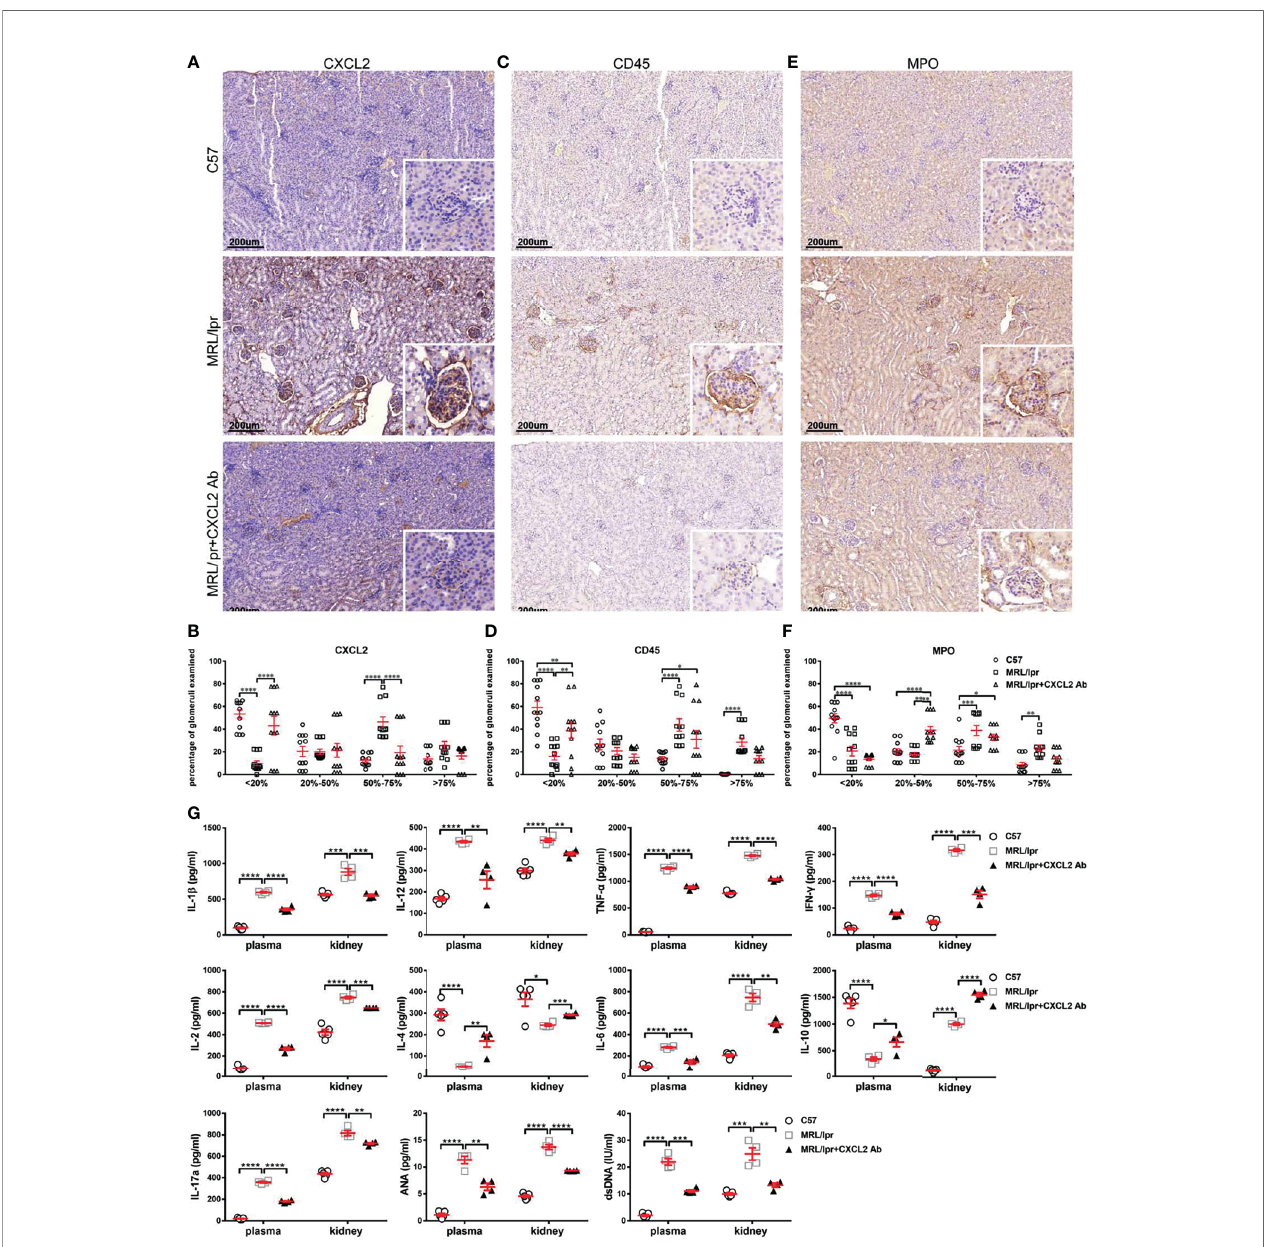
FIGURE 6 | Treatment with CXCL2 antibody inhibits in fl ammatory cytokine production in the MRL/lpr lupus model. (A, C, E) Representative images of CXCL2 (A) , CD45 (C) , and MPO (E) staining of kidney sections of mice from different groups. Inserts, details of a typical staining of the glomerulus. (B, D, F) Quantitative analysis of CXCL2 (B) , CD45 (D) , and MPO (F) deposition in the glomeruli in kidney sections. The glomeruli were classi fi ed into four categories according to the degree of straining. The glomerulus ratios in each category in different groups are summarized (n = 4 animals/group, 3 sections/animal). Data are presented as the mean ± SEM. **** P < 0.0001; *** P < 0.001; ** P < 0.01; * P < 0.05. (G) Concentrations of Th1 (including IL-1 b , IL-2, IL-12, TNF- a , and IFN- g ), Th2 (including IL-4, IL-6, and IL-10) and Th17 (IL-17) cytokines in the plasma and renal tissue homogenates of mice from different groups, determined by ELISA (n = 4 animals/group). Data are shown as the mean ± SEM. **** P < 0.0001; *** P < 0.001; * P < 0.01; * P <